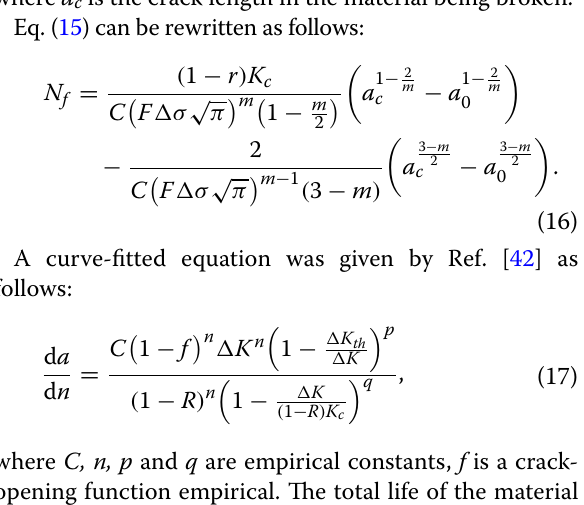
where a c is the crack length in the material being broken.